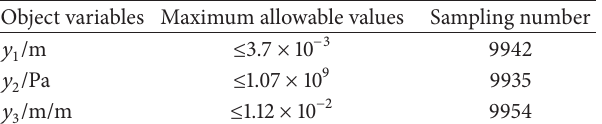
Table 2: Single-object sampling statistics of